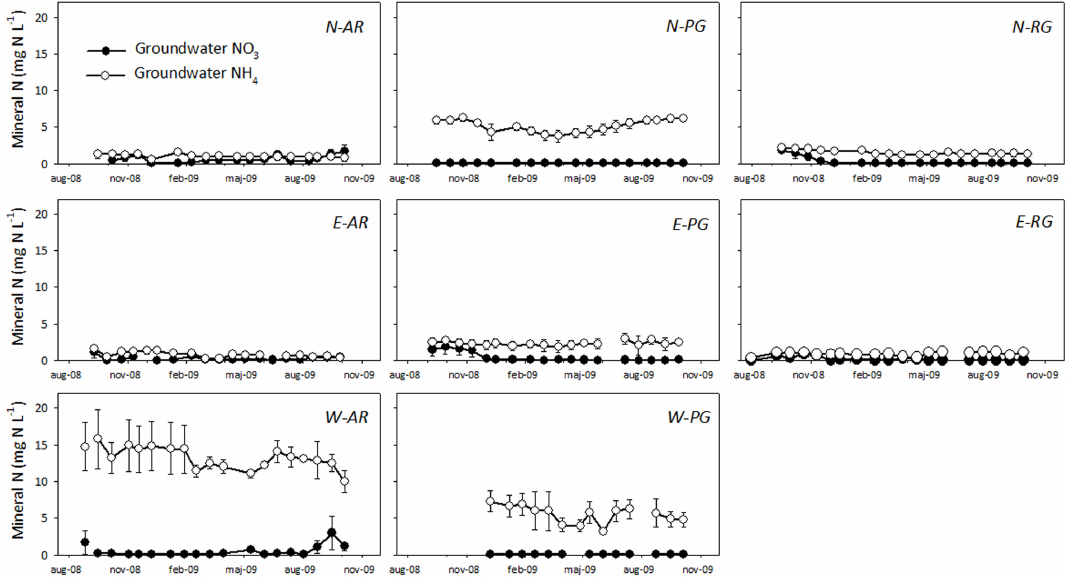
Fig. 5. Seasonal variations in groundwater ammonium (GW-NH + site ID, see legend to Fig. 2. Fresh groundwater was sampled from piezometers at the paired sampling points during gas flux measurement campaigns (the data shown represent mean ± standard error, n =